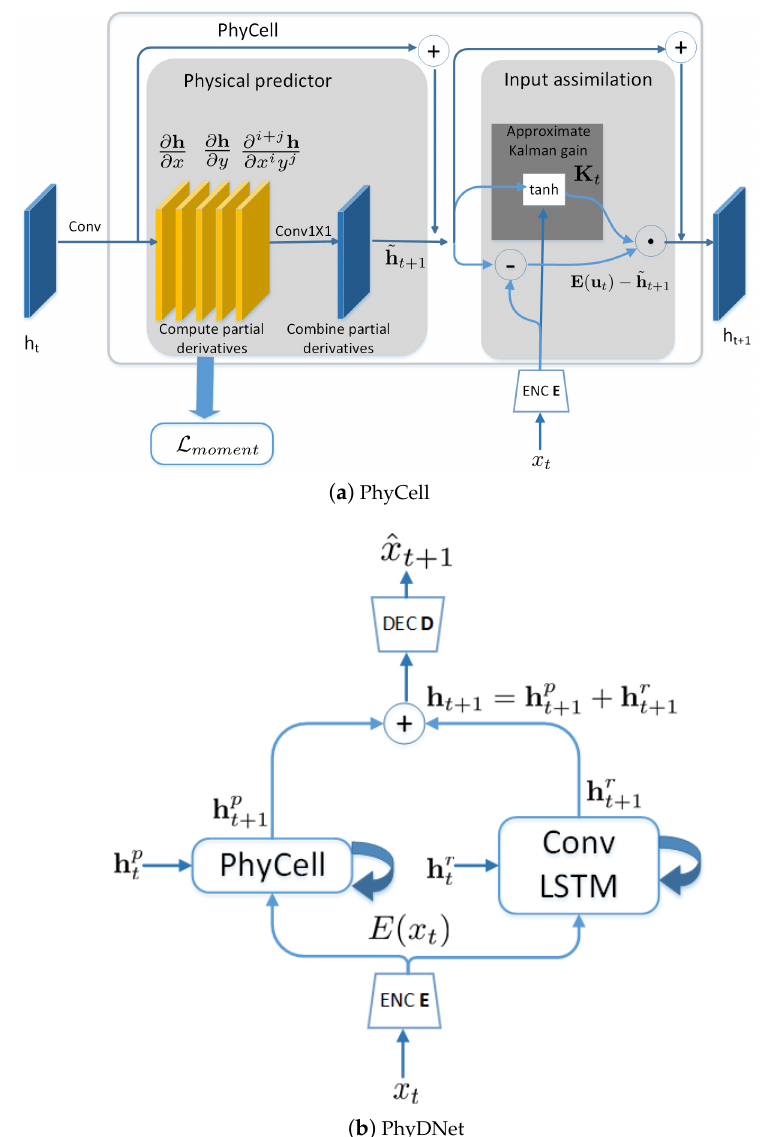
Figure 1. PhyCell for estimation of PDEs and PhyDNet for spatiotemporal